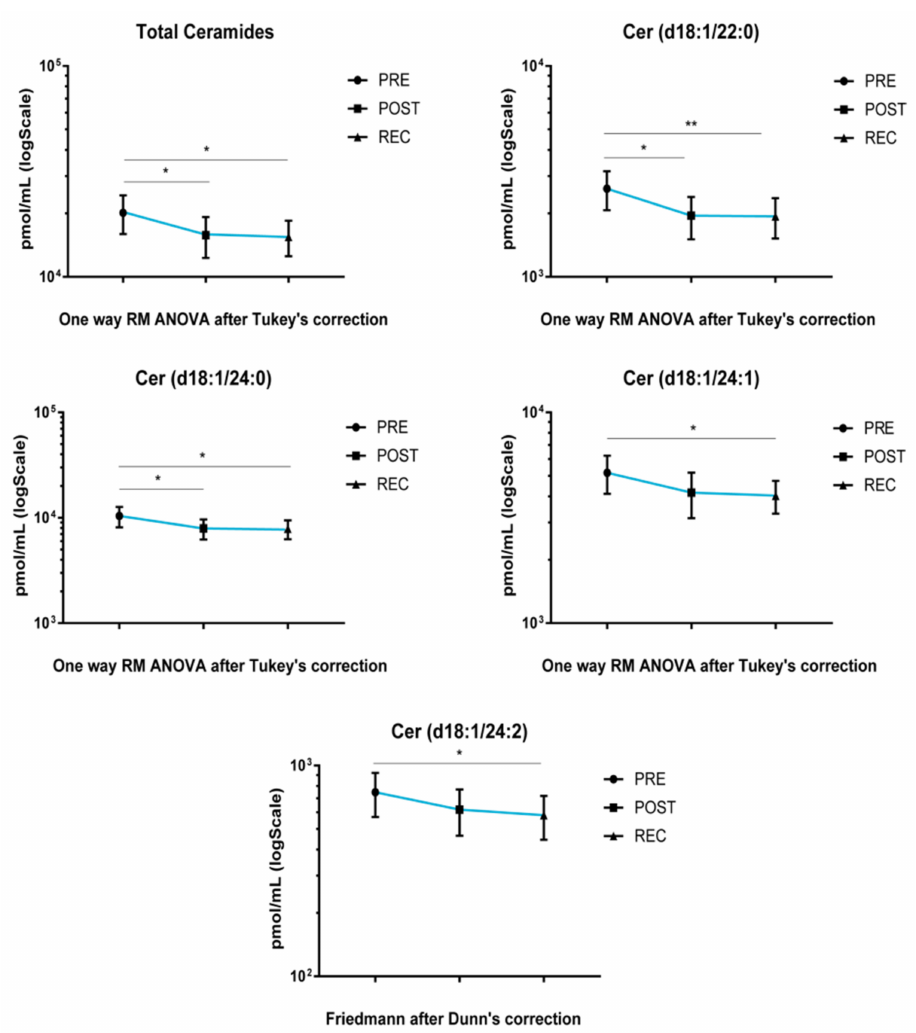
Figure 3. LC-MS analysis results for ceramides in serum of cocktail-treated subjects. Results are expressed as pmol/mL in Log scale (PRE n. 10, POST n. 10, REC n. 10). p -values are indicated as: * p -value < 0.05 and ** p -value <